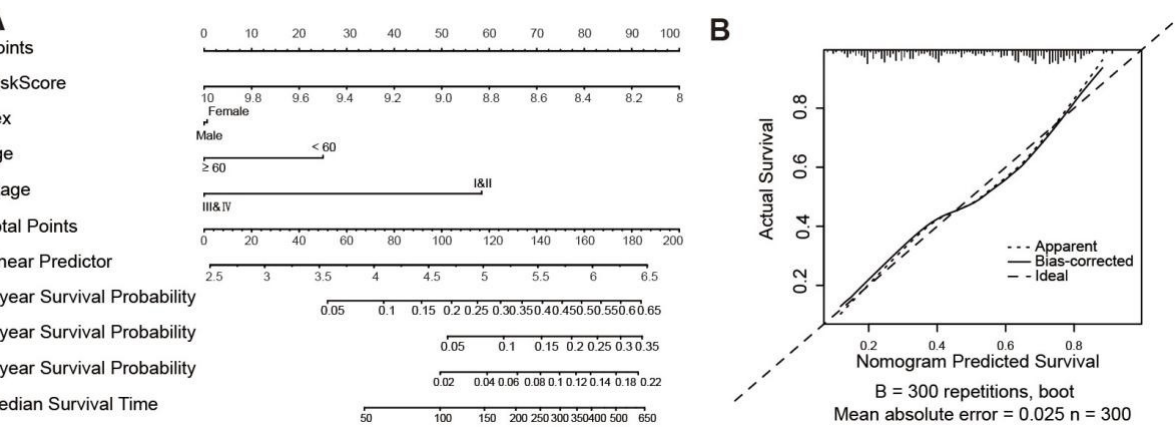
Figure 10. Nomogram for the prediction of outcomes of GC patients. ( A ) Nomogram for predicting survival that combines clinical data. ( B ) The calibration plots for predicting OS.